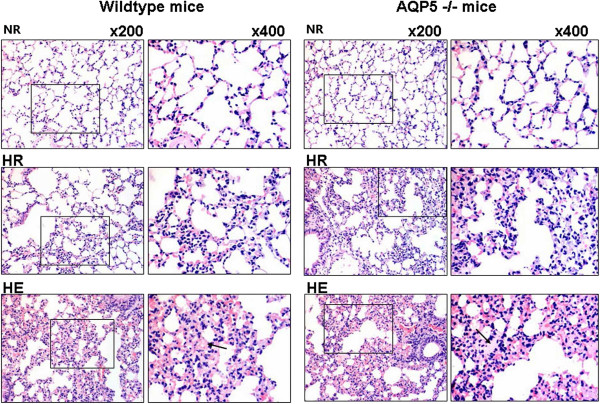
Lung histology in HAPE mice. Light micrograph of hematoxylin and eosin stained paraffin embedded section AQP5 −/− and wildtype vs. controls. The alveolar edema was shown by arrows. Magnification × 200 and × 400.